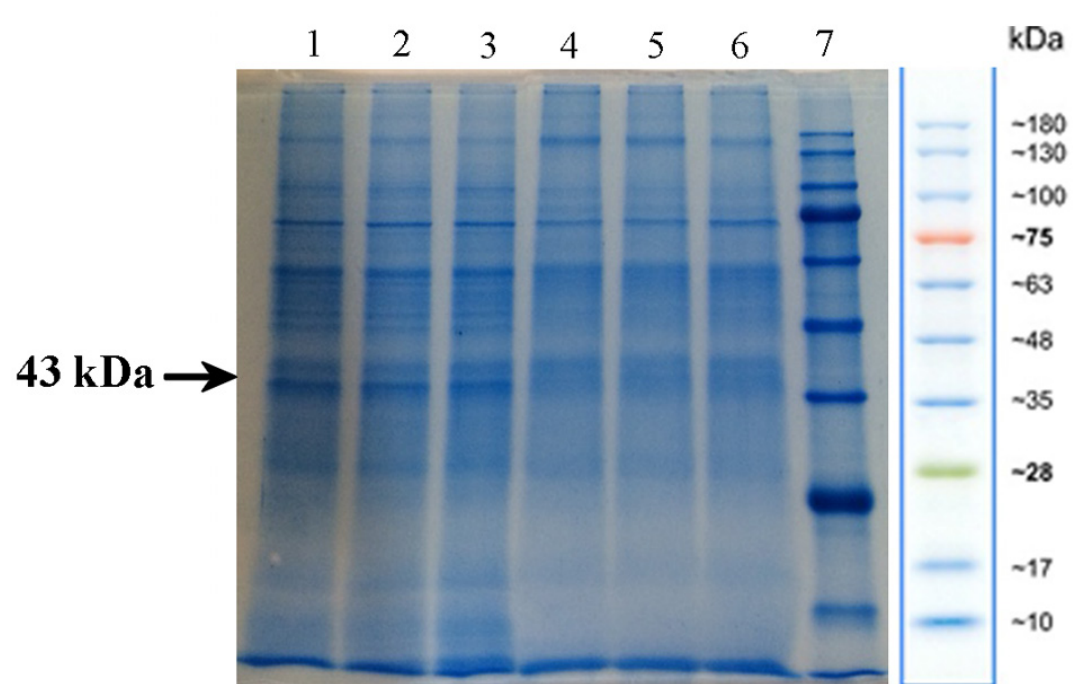
FIGURE 6 - SDS-PAGE analysis on different cultures in CD-DG44 and proCHO5 media. Lane 1, The CD-DG44 culture medium of the first FACS-sorted cells; Lane 2, The CD-DG44 culture medium of the second FACS-sorted cells; Lane 3, The CD-DG44 culture medium of clonal selected cells; Lane 4, The ProCHO culture medium of the first FACS-sorted cells; Lane 5, The ProCHO culture medium of the second FACS-sorted cells; Lane 6, The ProCHO culture medium of clonal selected cells; Lane 7, Prism Ultra Protein Ladder